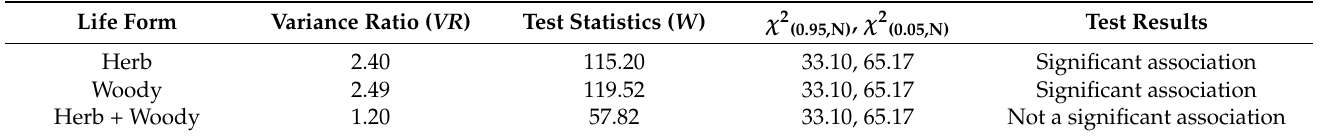
Table 3. Overall association of the 30 dominant species at the Ziwuling study area on the Chinese Loess Plateau.